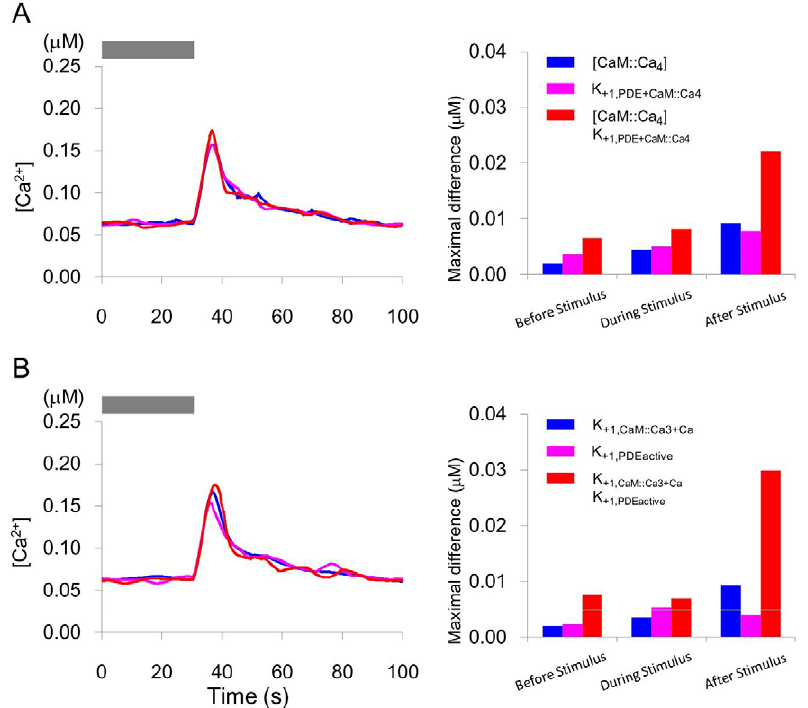
Figure 7. Synergistic effects of pairs of noise inputs. When pulse trains were added alongside different parameters or molecular concentrations, a synergistic increase in [Ca 2 + ] fluctuations was observed. Noises were applied simultaneously to A) CaM::Ca 4 and K + 1,PDE + CaM::Ca4 and B) K + 1,CaM::Ca3 + Ca and K + 1,PDEactive . Bar indicates the maximal difference between [Ca 2 + ] trace without noise and that with noise.